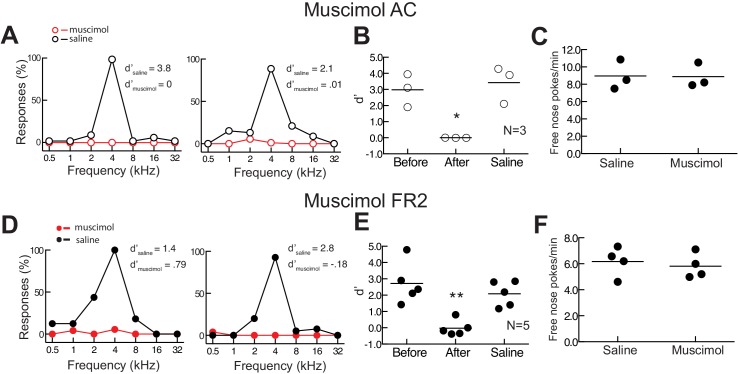
Bilateral infusion of muscimol into either AC or FR2 significantly impairs task performance.(A) Behavioral performance after muscimol infusion (red) or saline control (black) in AC from two individual animals. (B) Summary of performance on day before infusion, after muscimol infusion into AC, and after saline control infusion (N = 3 animals). Performance was impaired after muscimol infusion (p=0.03 Student’s paired two-tailed t-test, *p<0.05). (C) Behavior of one animal allowed to freely nose poke for food without tones being presented. This behavior was not affected by muscimol inactivation (average of three sessions, p>0.99 Wilcoxon matched-pairs signed rank test). Error bars represent S.E.M. (D) Behavioral performance for two animals infused bilaterally with muscimol into FR2. (E) Summary of performance before, during, and after muscimol infusion into FR2 (N = 5 animals). Performance was impaired after muscimol infusion (p=0.009 Student’s paired two-tailed t-test, **p<0.01). (F) Muscimol in FR2 did not impair free nose poking for food without tones being presented in two animals (average of four sessions, p=0.62, Wilcoxon matched-pairs signed rank test).